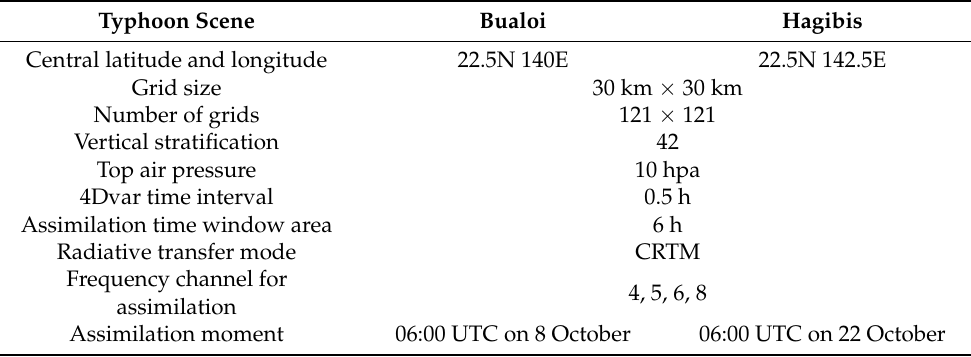
Table 7. The parameter settings of WRFDA-4Dvar assimilation